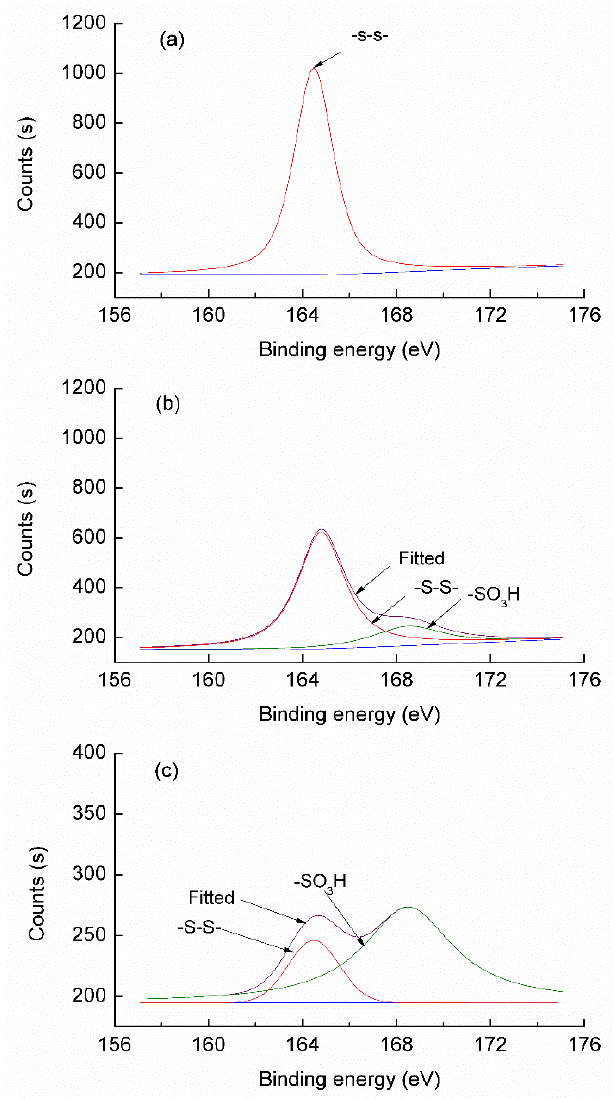
Figure 7. Element S 2p spectra of wool fibers XPS ( a ) control ( b ) exhaustion treated ( c ) padding